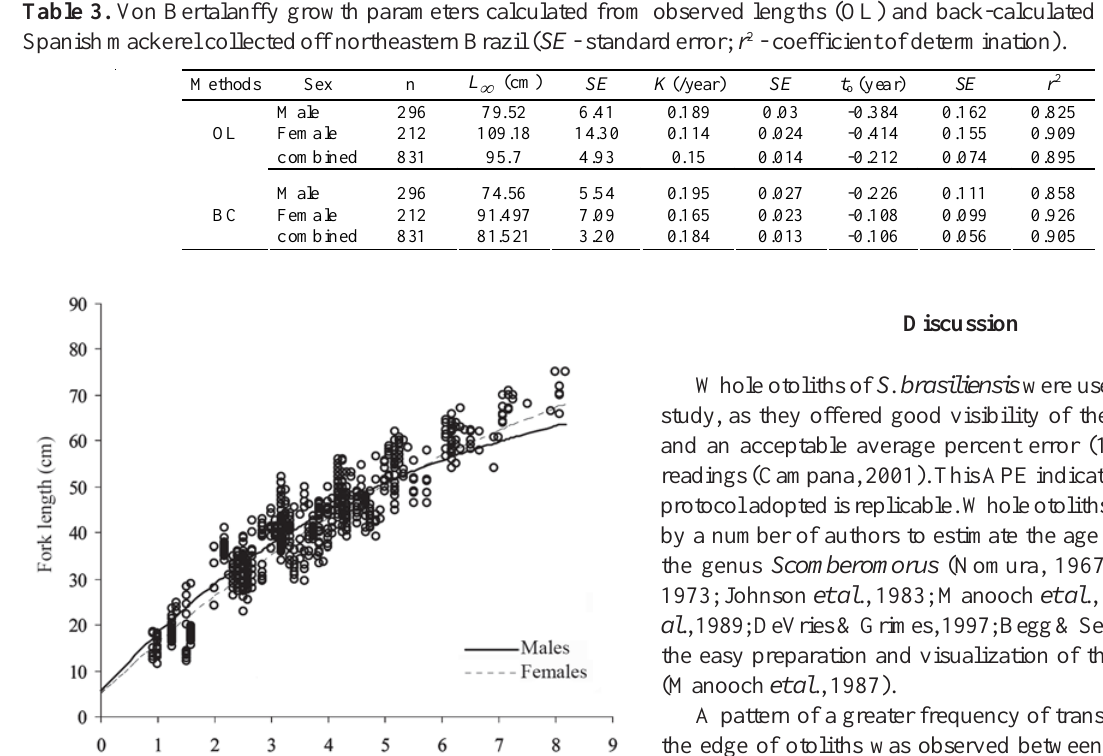
; z = relative growth 1 2